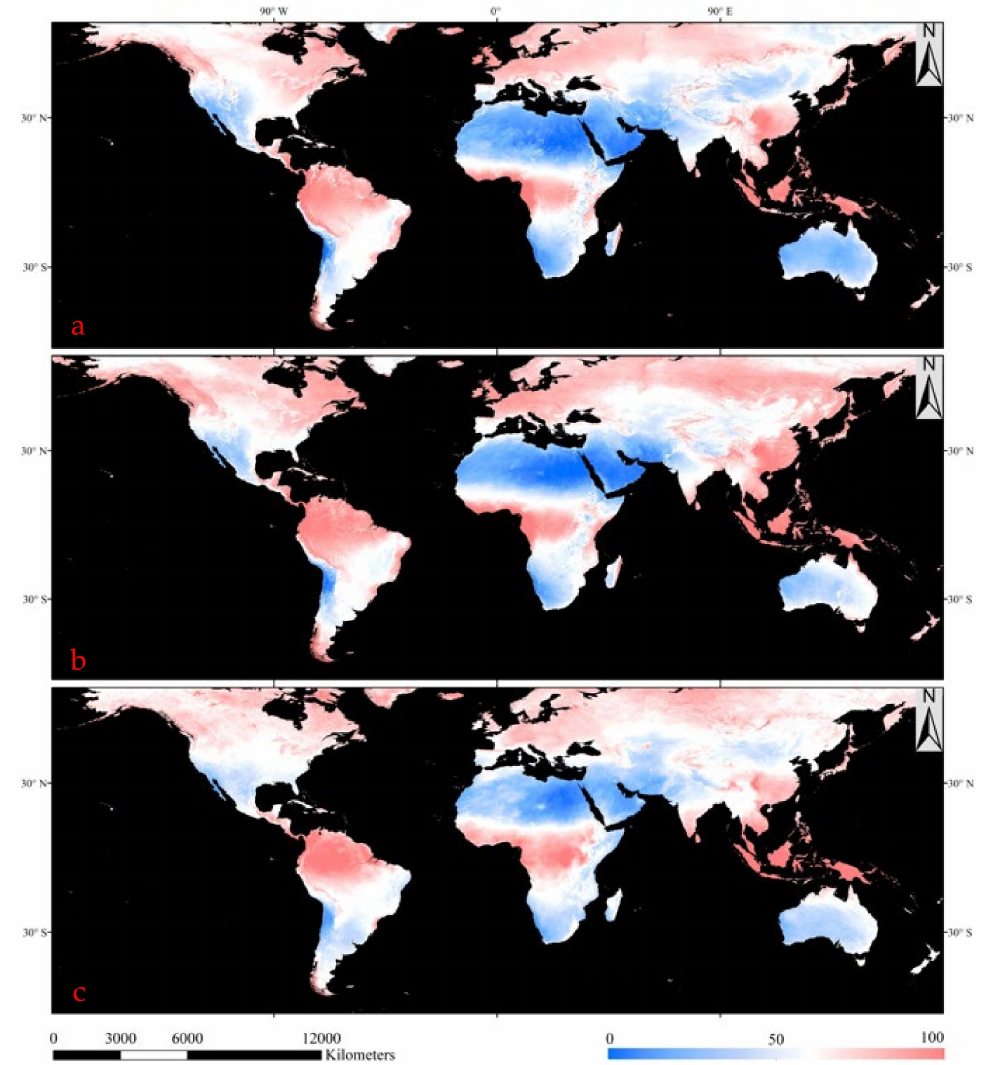
Figure 20. Average global cloud frequency (%) of GLHCC ( a ), MOD/MYD35 ( b ), and PATMOS-X ( c ) in 2010.